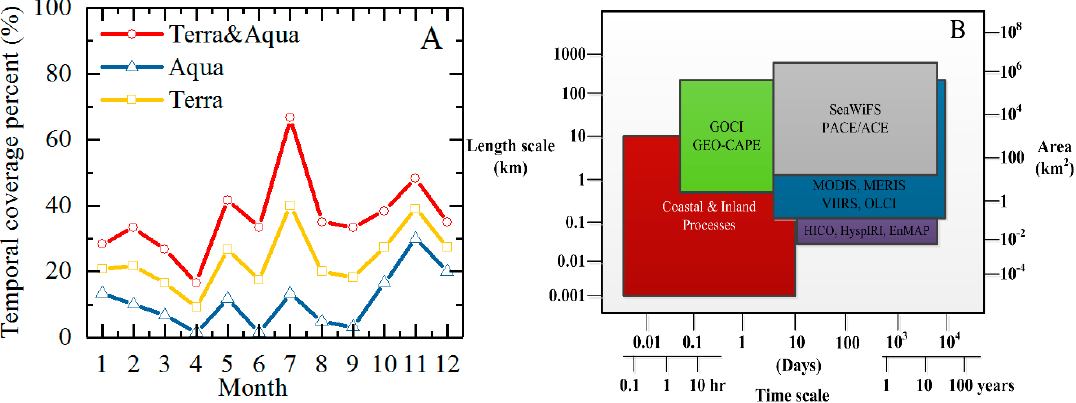
Figure 1. Temporal coverage of Terra/ Aqua MODIS over Deep Bay ( A ), and spatial-temporal variation scales of coastal/inland waters ( B ) (reproduced from Mouw, 2015, [14]).